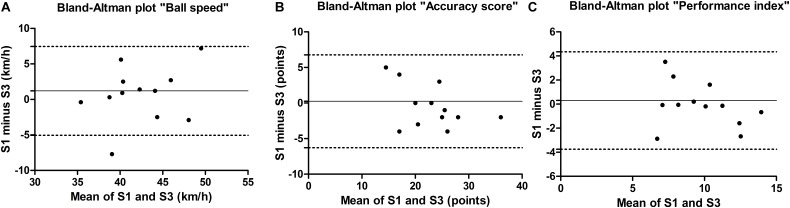
Bland–Altman plots for (A) ball speed, (B) accuracy score, and (C) performance index. The continuous line represents the mean difference between the first series of the first session (S1) and the first series of the second session (S3). The dotted lines represent the 95% limits of agreement (n = 12).